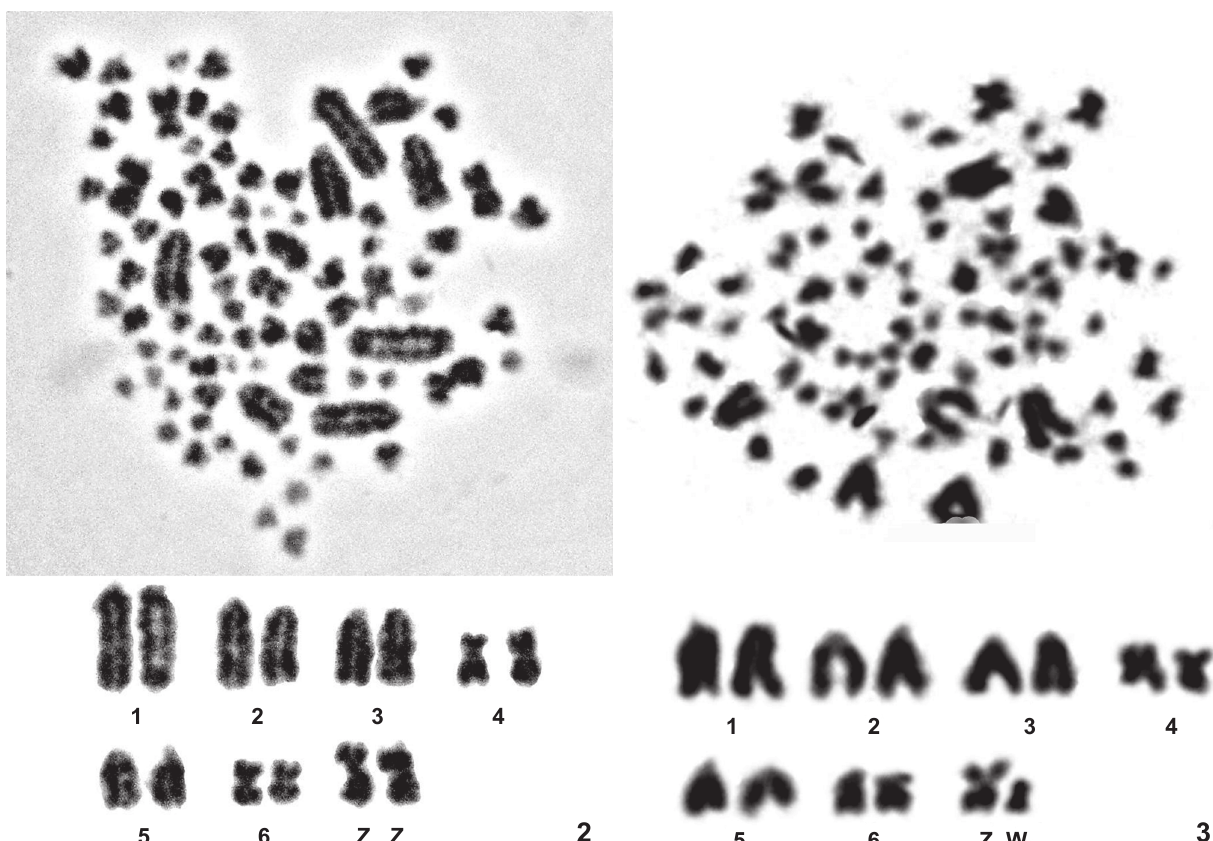
Figures 2-3. Metaphase and karyotype of: (2) a male of A. cunicularia with leucism, 2n = 84, ZZ; (3) a female of A. cunicularia , 2n = 84, ZW. The sexual W chromosome is metacentric and comparable in size with the seventh